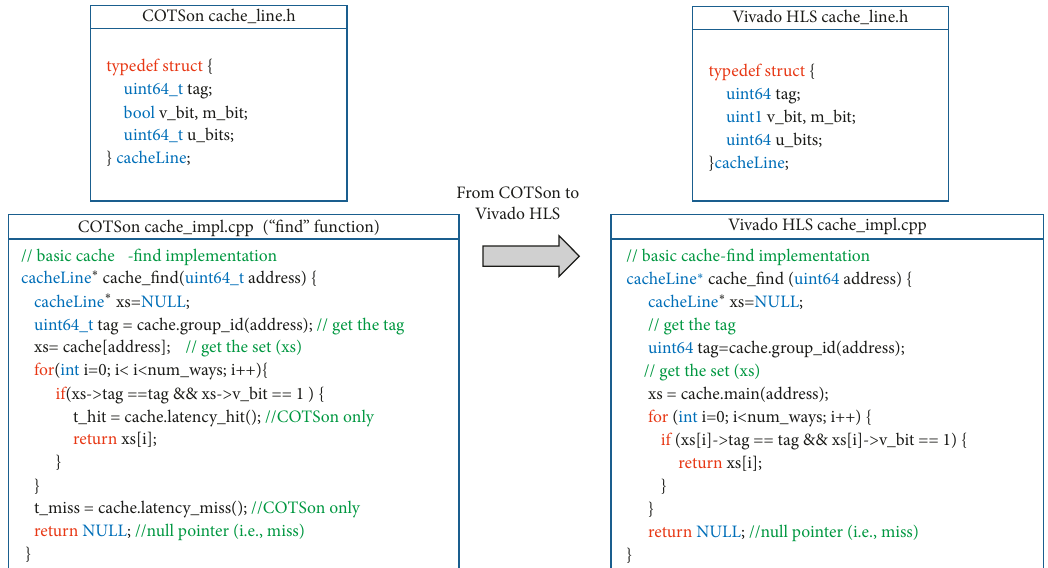
Figure 7: Example of the timing model of the cache “find” function, which is translated from the COTSon to the Vivado HLS. The implementation of this function for both the COTSon (left) and Vivado HLS (right) environments is shown in the bottom part of the figure.